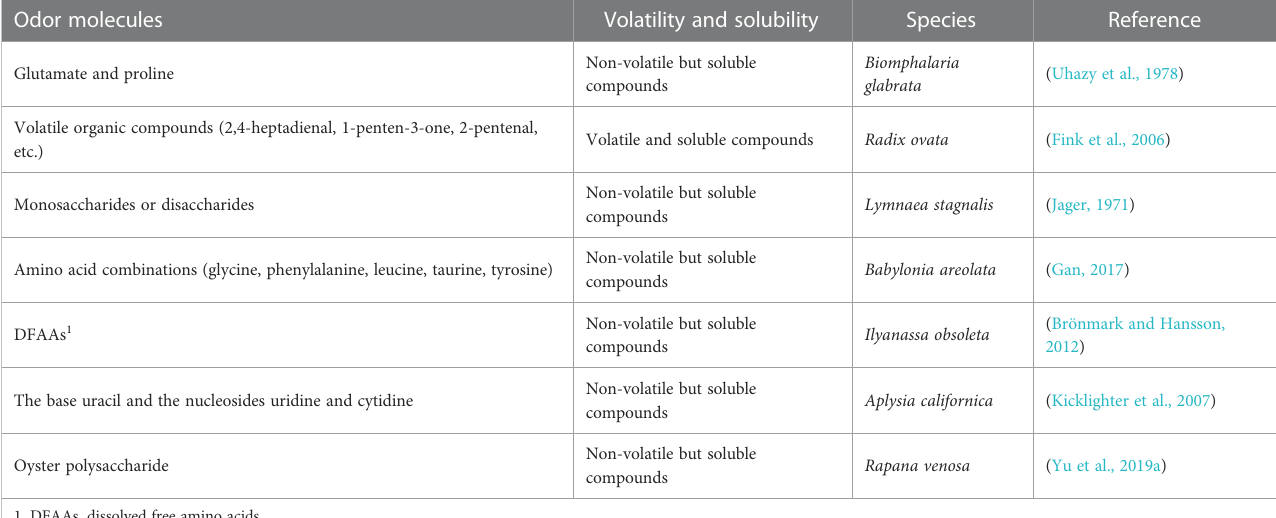
TABLE 1 Chemical molecules that induce chemoreception behavior in aquatic